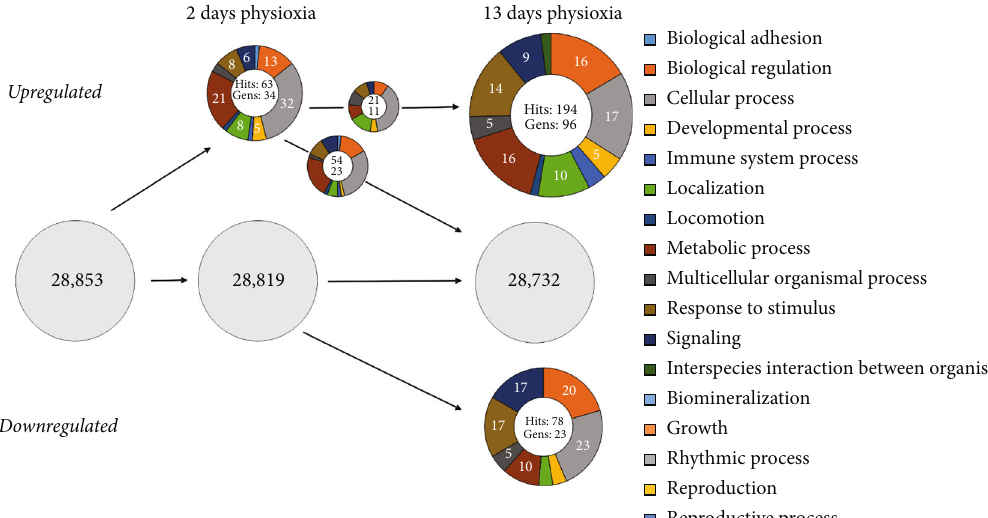
Figure 4: Global comparison of PANTHER gene categories “ biological process ” in cortical NSC cultures. Displayed are percentages of hits from oxygen-regulated genes to speci fi c categories according to the PANTHER domain “ biological process. ” The PANTHER classi fi cation includes the total up-/downregulated genes (lower number in the inner circle) with at least a twofold di ff erence for short- and long-term cultures. The grey circles indicate all analysed genes without a change of expression due to O gene was downregulated in hypoxic cells, but 9 genes from di ff erent categories were upregulated, which formed a total of 31 hits. 3 genes and 14 hits of them were also upregulated in hypoxic prolonged cultures, while the other 6 genes did not undergo any O prolonged cultures. In total, 226 genes were upregulated and formed 529 hits, and 112 genes with 272 hits were downregulated after 13 days of hypoxic culture (13 d). The hits result from the multiple biological functions of a gene. Since a gene can also have multiple functions, one gene also often results in multiple hits. Also shown are the percentages of individual hits in di ff erent biological functions (categories) to the total hits of the regulated